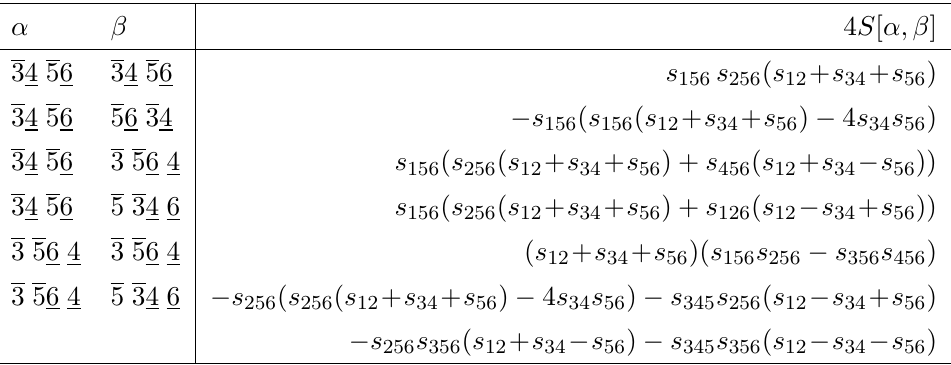
Table 2 . The momentum kernel for the gravitational amplitude M n =6 ;k =3 . Only the six key entries are shown, the other ten are obtained by